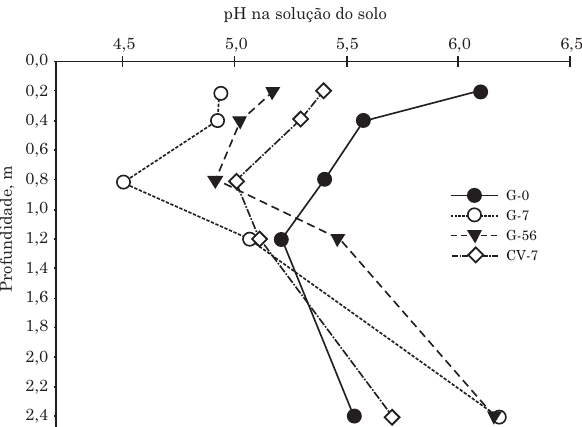
Figura 1. Valores de pH na solução do Latossolo Vermelho distrófico em função das doses de gesso utilizadas (G-0: gesso no preparo e sem gesso na linha de plantio; G-7: gesso no preparo e 7 t ha -1 de gesso na linha de plantio; G-56: gesso no preparo e 56 t ha -1 de gesso na linha de plantio; e CV-7: ausência de braquiária